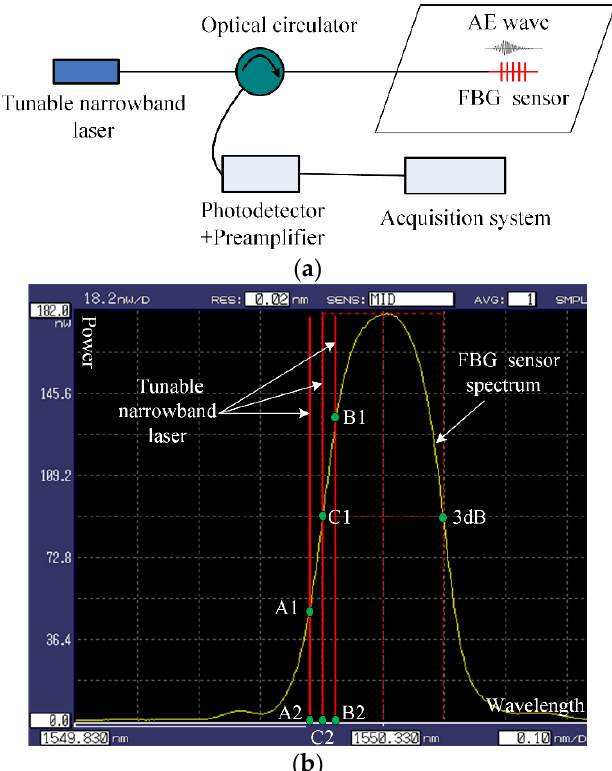
Figure 4. Tunable narrowband laser detection system and its illustrative diagram. ( a ) Single channel FBG sensor system; ( b ) Illustrative diagram.